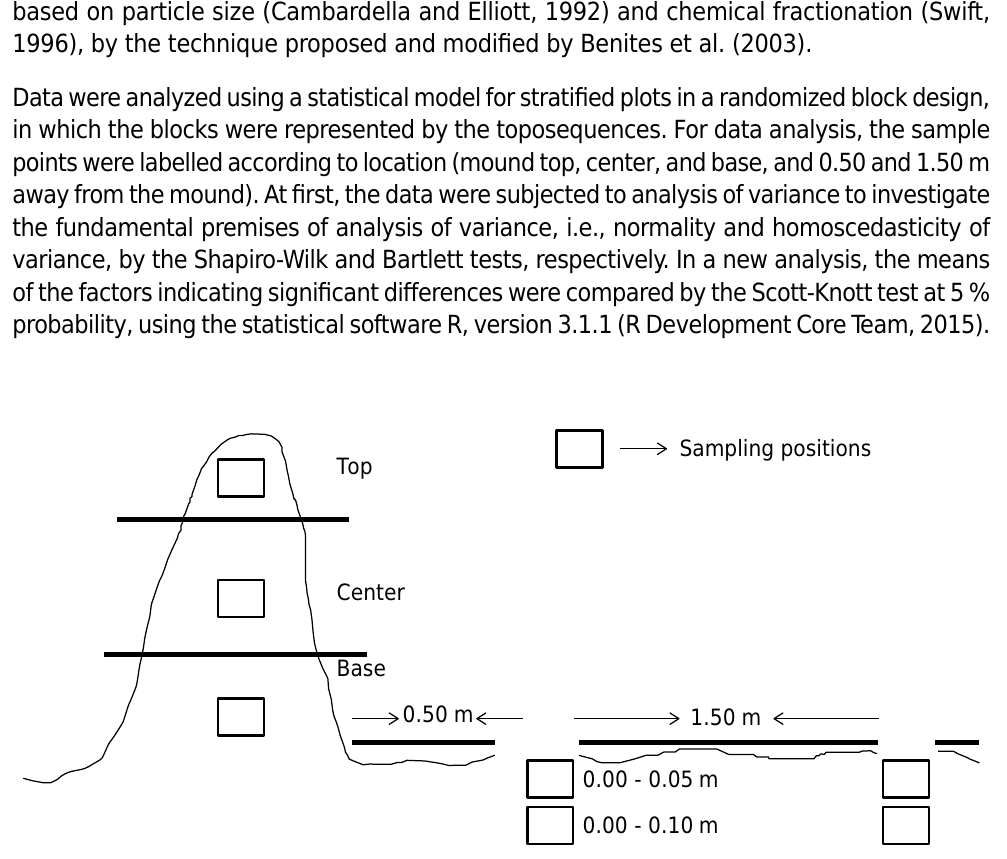
Figure 1. Sampled sections of a termite mound (top, center, and base) and the adjacent soil at two distances and